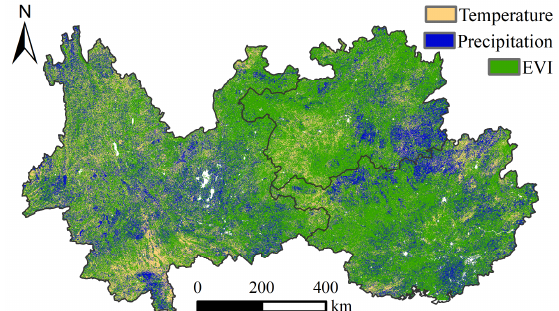
Figure 5. Spatial distribution of dominant factors influencing variations in ecosystem WUE.